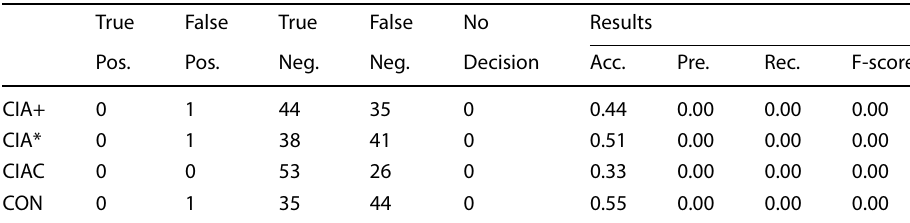
Table 5 Binary classifications and results: phishing data